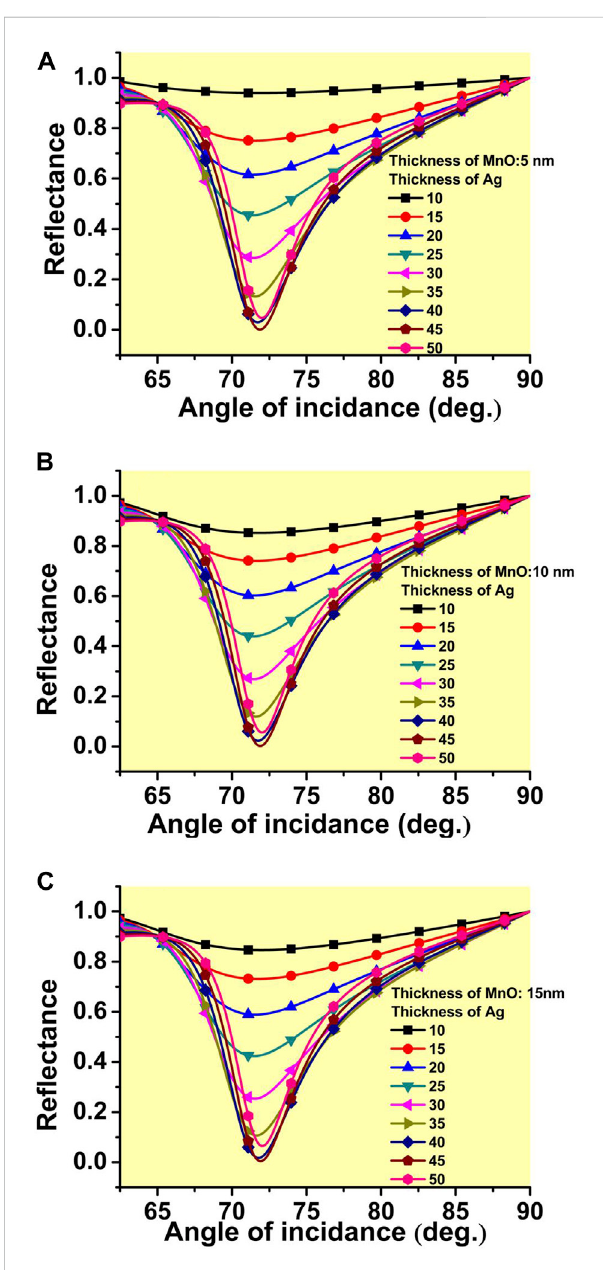
FIGURE 2 The optimization of the thickness of the Ag metal placed on the adhesion layer of MgO having a thickness. (A) 5 nm, (B) 10 nm, and (C) 15